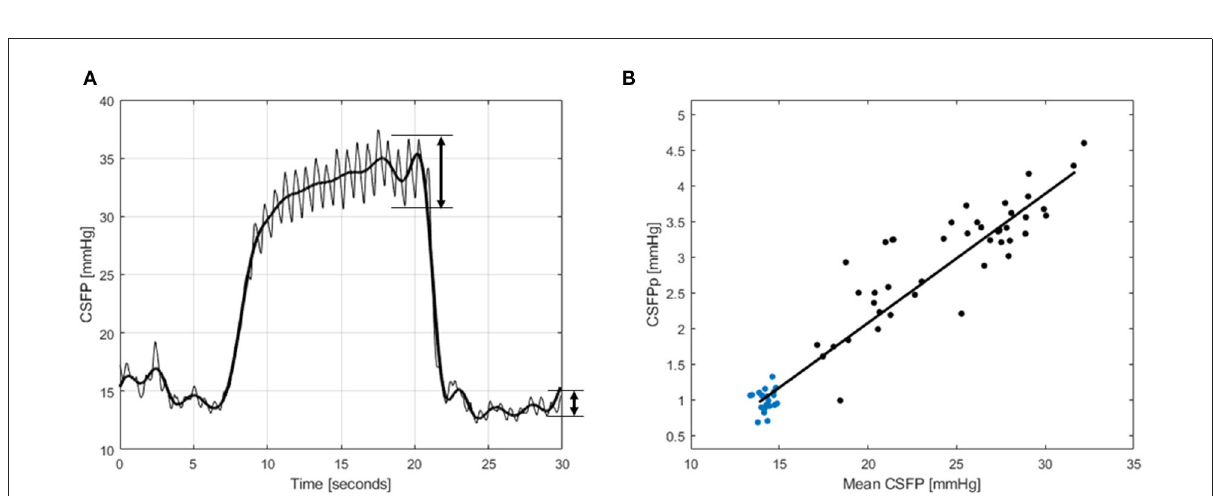
FIGURE3 A schematized illustration for the CSF pressure (CSFP) metrics from a spine-healthy patient. In (A) , CSFP is shown, the bold line is mean CSFP, and the cardiac-driven CSFP amplitude is shown at the end of the Queckenstedt’s maneuver (20s) and at the end of the recording, where CSFPp is calculated by subtraction of peak values from the previous trough. In (B) , the pulsatility curve is shown for the same CSFP recording, where the blue points are values from the steady state and the black points are from the Queckenstedt’s test. The slope of the line fitted to the points is